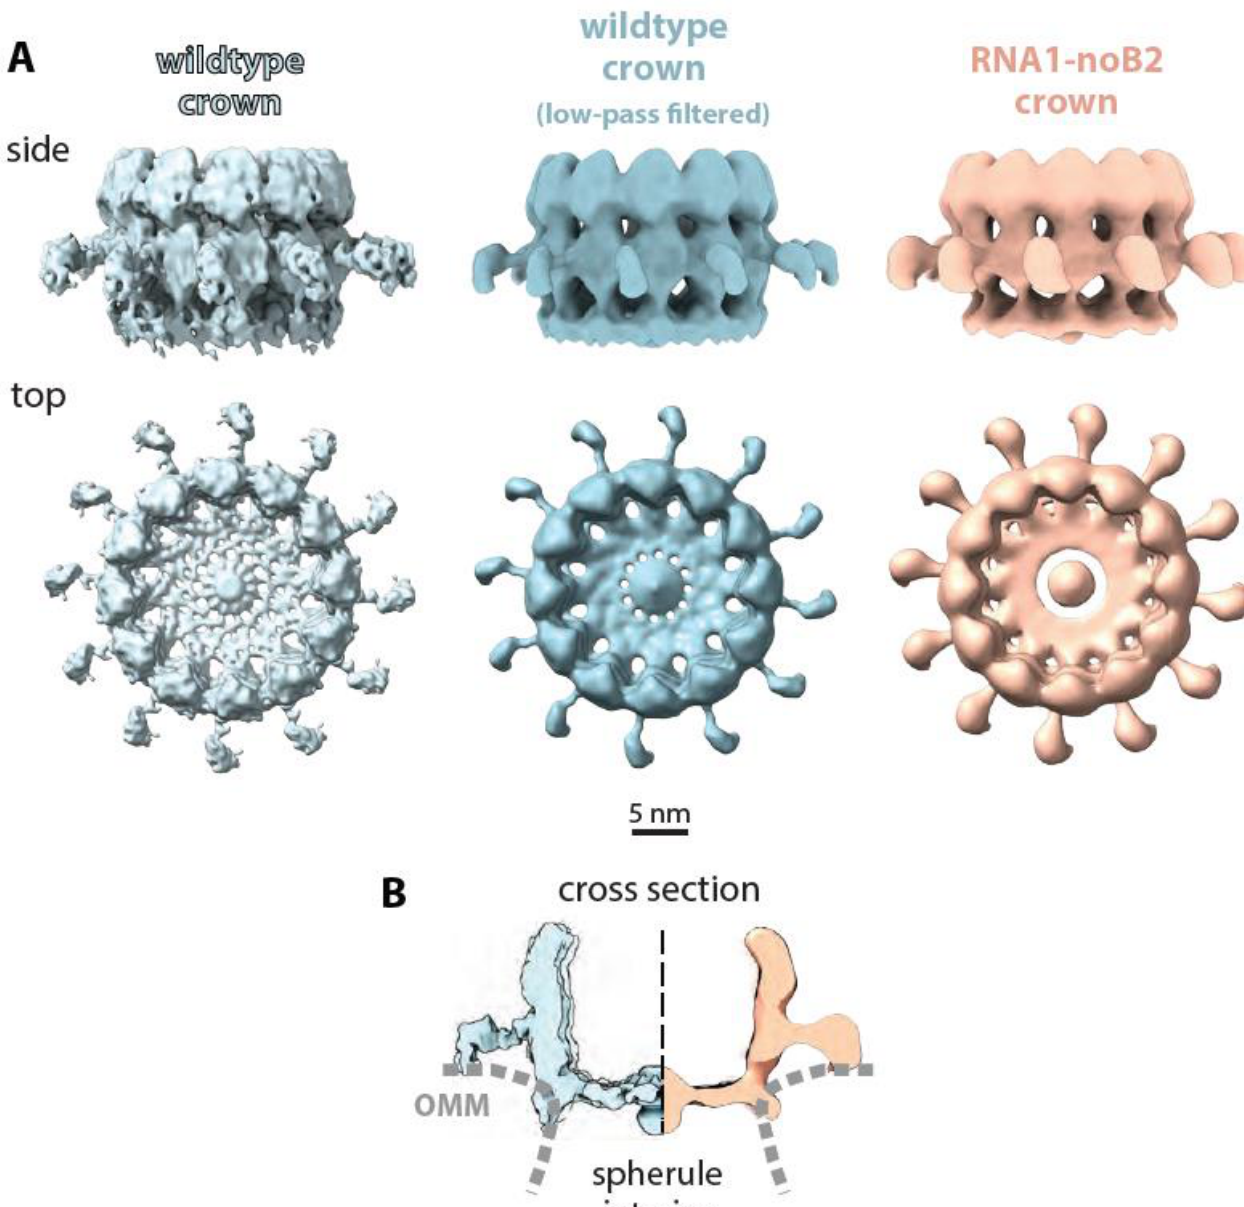
Figure 6. Comparison of nodavirus RNA replication complex crowns formed in nodavirus-infected insect cells to those formed in mammalian cells in the absence of Protein B2 and genomic RNA2. ( A ) On the right, light orange side and top view presentations of RNA1-noB2 replication-induced crowns in mammalian cells display all of the hallmark 12-fold symmetrical features of wildtype FHV infection-induced RC crowns shown in the published high-resolution crown image [24] on the left and the matched low-pass gaussian-filtered, slightly lower resolution version in the center. As shown, these common features include the apical and basal lobes of the central turret, inner floors with similar diameter central openings and central densities, and leg-like radial extensions. ( B ) Cross-sectioned comparison to further illustrate the matching shapes and membrane interactions of the high-resolution wildtype crown (leftmost images in panel ( A )) and the RNA1-noB2 crown structures. OMM = outer mitochondrial membrane.